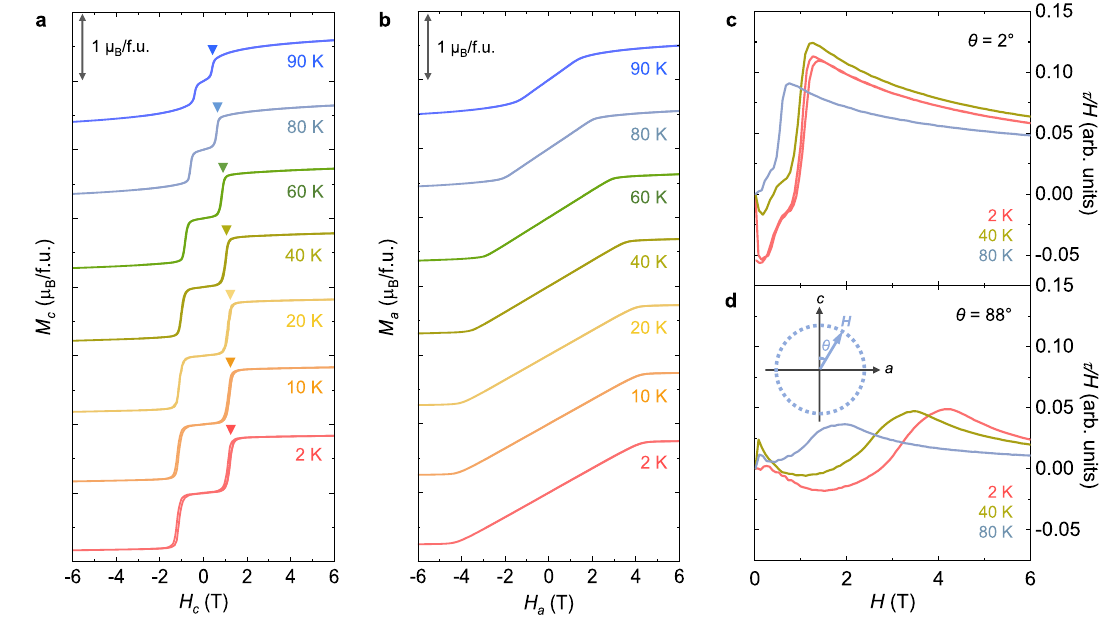
Figure 3. Temperature evolution of anisotropic magnetizations and anisotropic magnetic torques. ( a ) Isothermal M c measured at various temperatures, T = 2, 10, 20, 40, 60, 80, and 90 K. The M c data are shifted vertically for clear visualization. A marked scale indicates 1 μ B /f.u. Inverted triangles represent the occurrence of H flip at each T . ( b ) Isothermal M a measured at various temperatures, T = 2, 10, 20, 40, 60, 80, and 90 K. ( c ) Magnetic torque divided by the magnetic field, τ/H , measured at θ = 2° for T = 2, 40, and 80 K. ( d ) Magnetic torque divided by the magnetic field, τ/H , measured at θ = 88° for T = 2, 40, and 80 K. Inset shows the geometry of applied H in the ac plane. θ = 0° for the c -axis and θ = 90° for the a